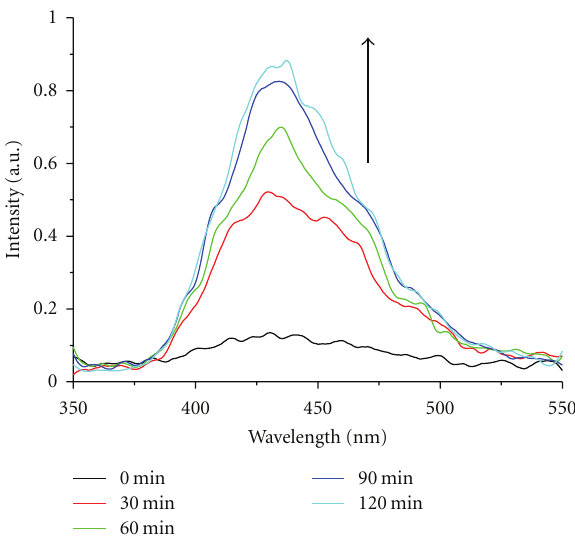
Figure 11: PL spectral changes with irradiation time over Nd- doped TiO 2 with Ti:Nd = 11 :1 in terephthalic acid solution of 5 × 10 − 4